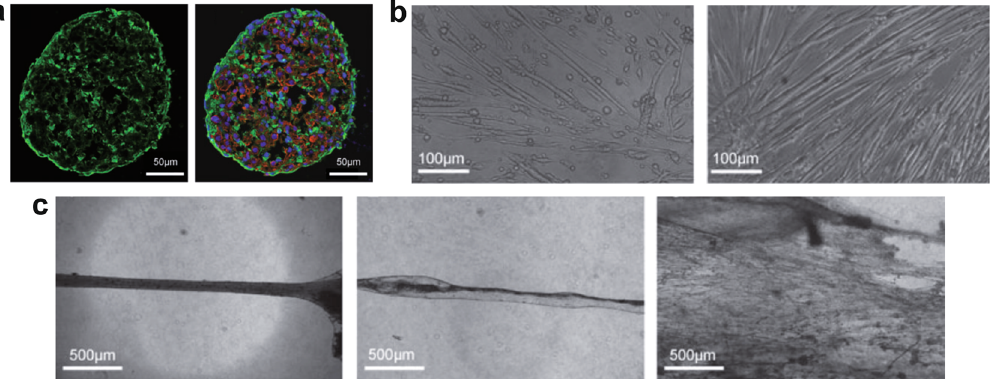
Fig. 7 Fibroblast co-culture with skeletal muscle cells: in fl uence on myogenesis. a Fluorescence images of enhanced-GFP-expressing mouse embryonic fi broblasts (MEFs) evenly distributed in a co-culture with primary mouse myoblasts (PMM), stained for fast myosin heavy chain (red) and nuclei (blue). b 2D myotube monocultures degenerated after 18 days in culture (left), while the presence of fi broblasts in co- culture drastically enhanced their stability (right). c Left: MEF/PMM co-culture led to the assembly into a 3D fi brin construct with consequent fi brin degradation. MEF monoculture assembled in a 3D construct (middle), but PMM monoculture without MEFs did not show any 3D autoassembled construct or fi brin degradation (right). Images adapted and reproduced with permission from 188